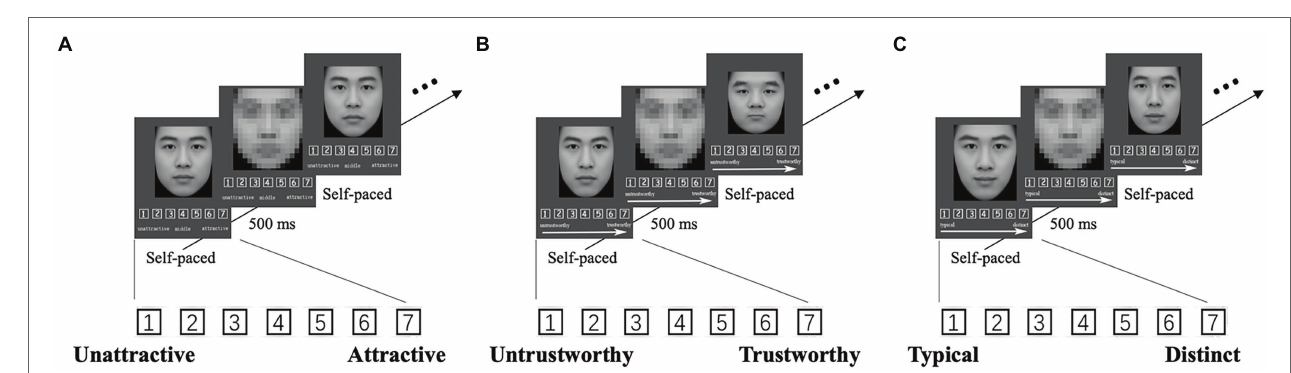
FIGURE 2 | The procedure of face judgments. (A) The procedure of attractiveness judgments, (B) the procedure of trustworthiness judgments, and (C) the procedure of typicality judgments. A seven-point Likert scale was used for all trait